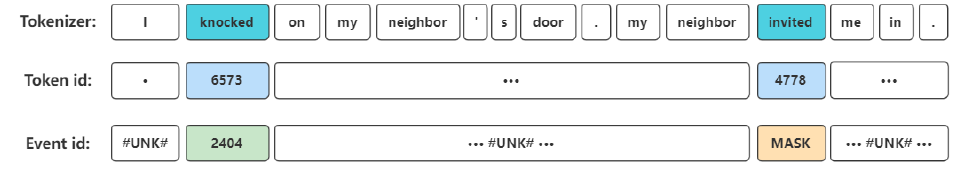
Figure 3. Alignment of an input